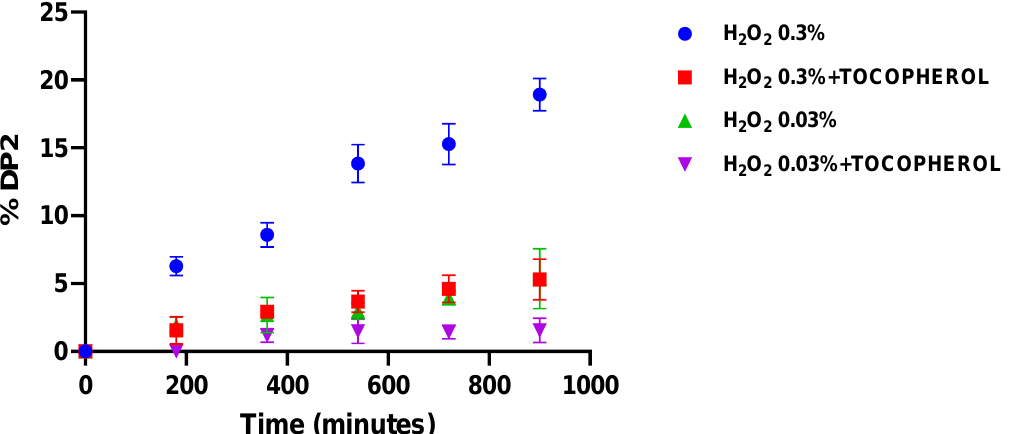
Figure 4. Percentage of degradation product formed under oxidative stress (DP2) as a function of time and in the presence of tocopherol.